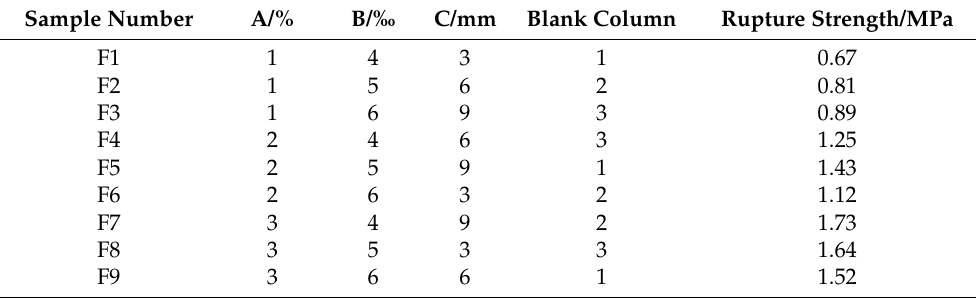
Table 9. Orthogonal test